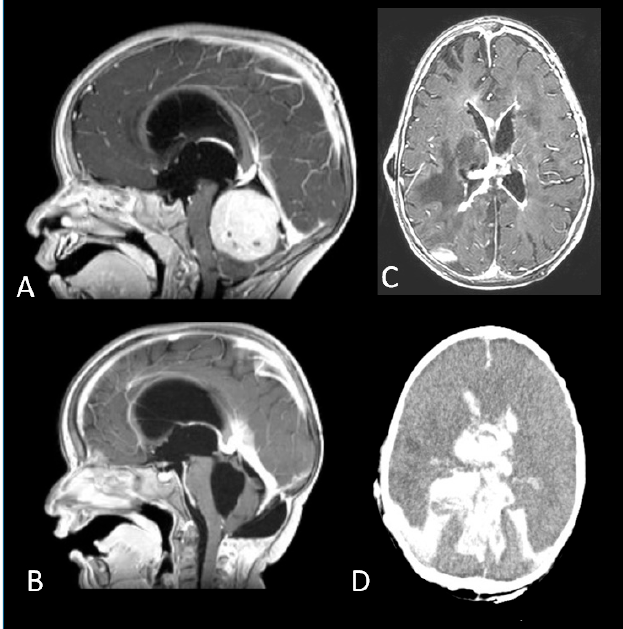
Figure 5. ( A ). A fourth ventricular tumour arising from the cerebellar vermis. ( B ). Complete Resec- tion of a desmoplastic medulloblastoma. ( C ). Mycotic ventriculitis ( D ). Intraventricular haemor-